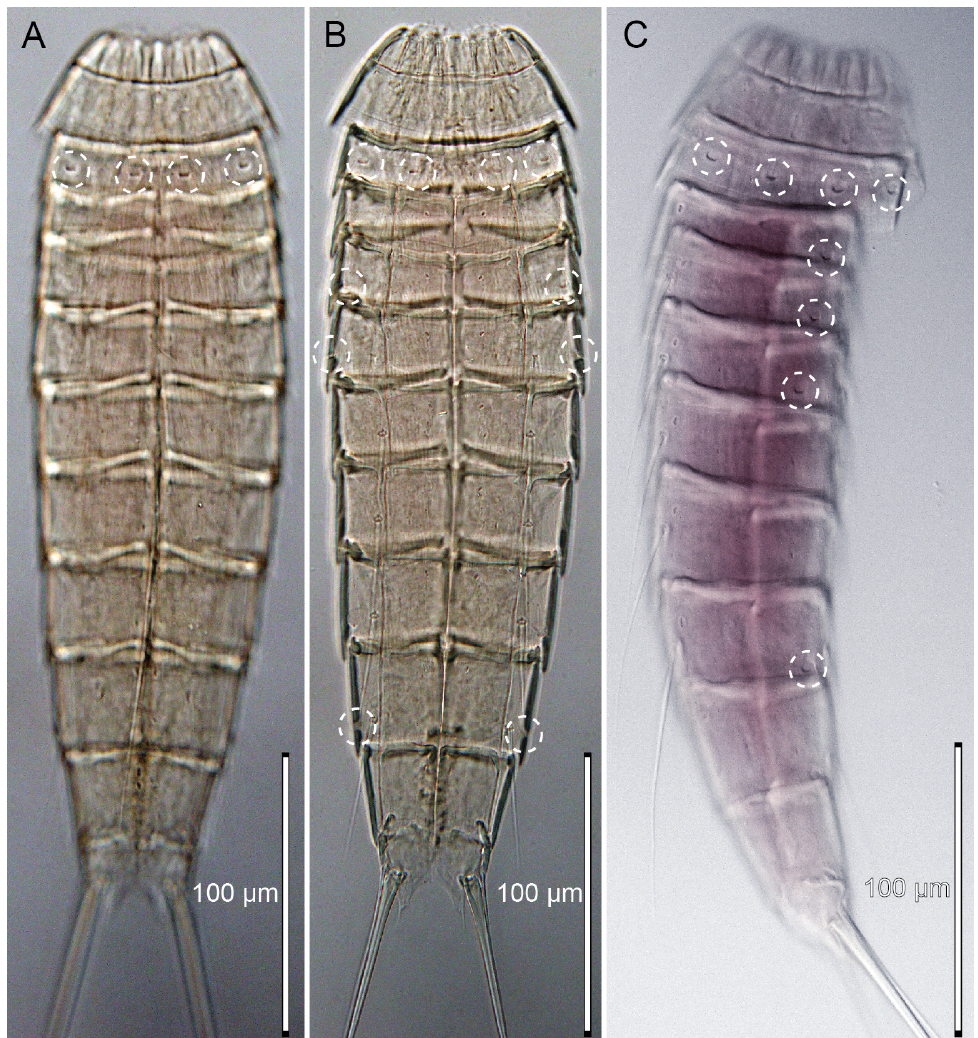
Fig. 15. Light micrographs showing overviews of Echinoderes juliae sp. nov., holotype, ♀ (A–B) (NHMD-213666) and paratype, ♀ (C) (NHMD-213689). A . Dorsal overview. B . Ventral overview. C . Lateral view. Glandular cell outlets type 2 are marked with dashed white circles. Fig. 16 (opposite page). Light micrographs showing overviews and details of Echinoderes juliae sp. nov., holotype, ♀ (A–B, D–E, G–H) (NHMD-213666), paratype, ♀ (C) (NHMD-213689), paratype, ♂ (F) (NHMD-213686) and paratype, ♀ (I) (NHMD-213684). A . Segments 1 to 5, dorsal view. B . Segments 1 to 5, ventral view. C . Segments 1 to 6, lateral view. D . Segments 5 to 7, dorsal view. E . Segments 5 to 7, ventral view. F . ♂, segments 10 to 11, ventral view. G . Segments 8 to 10, dorsal view. H . Segments 8 to 10, ventral view. I . ♀, segments 10 to 11, ventral view. Abbreviations: ldgco2 = laterodorsal glandular cell outlet type 2; ldss = laterodorsal sensory spot; ltas = lateral terminal accessory spine; lts = lateral terminal spine; lvs = lateroventral spine; lvt = lateroventral tube; mdgco1 = middorsal glandular cell outlet type 1; mds = middorsal spine; mlgco2 = midlateral glandular cell outlet type 2; pdgco1 = paradorsal glandular cell outlet type 1; pdss = paradorsal sensory spot; pe = penile spines; pvgco1 = paraventral glandular cell outlet type 1; sdgco2 = subdorsal glandular cell outlet type 2; sdss = subdorsal sensory spot; slgco2 = sublateral glandular cell outlet type 2; te = tergal extensions; vlgco2 = ventrolateral glandular cell outlet type 2; vlss = ventrolateral sensory spot; vmgco1 = ventromedial glandular cell outlet type 1; vmss = ventromedial sensory spot.